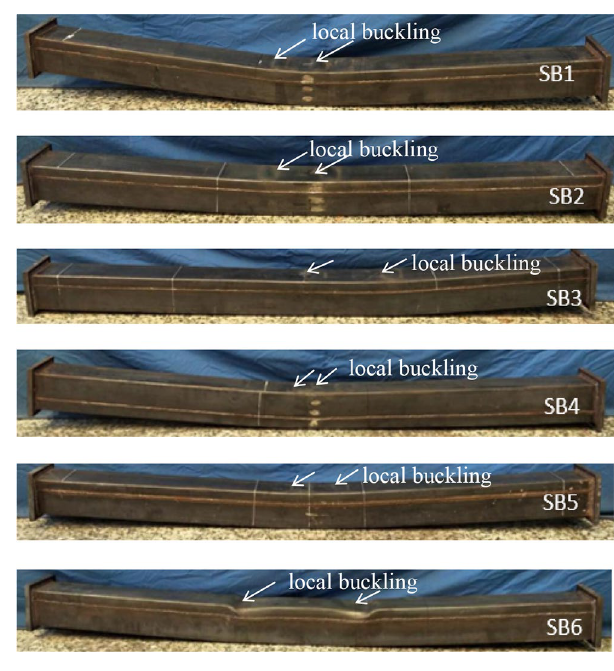
Figure 3. Failure modes of specimens.